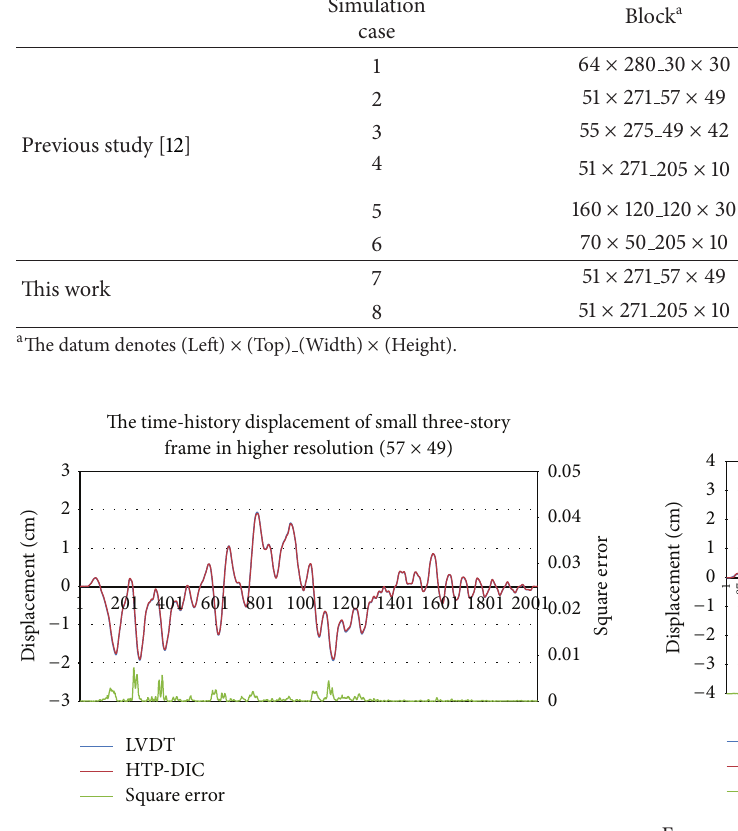
Figure 12: Time history of displacement and square error of displacement of small three-story frame at high resolution (57 × 49).